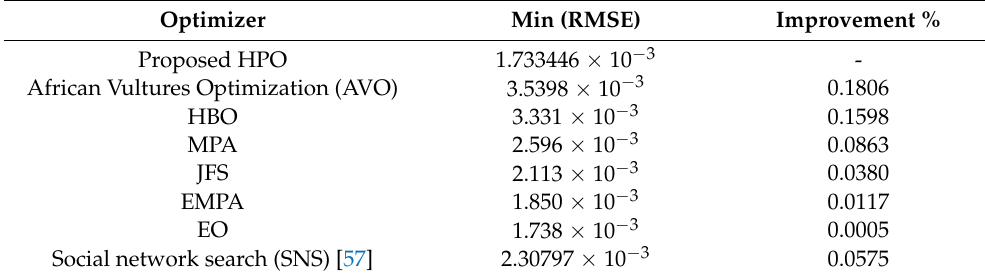
Table 6. Optimal values of extracted parameters by HPO technique for the triple-diode model of Table 7. Comparative assessment of the proposed HPO technique versus recently reported optimizers STM6-120/36. for the triple-diode model with STM6_40/36 PV module.